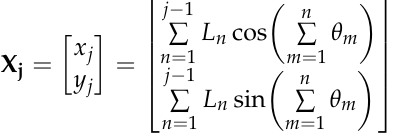
We define the base link as j = 1, where ( x 1 , y 2 ) = (0,0). L j is the length of link j , which appends to joint j , and where θ j is the relative angle between link j and j − 1. Note that for j = N + 1, we obtain the position of the end-effector p with respect to the world frame. Rastegar et al. used the Monte Carlo method [14] while relying on uniformly distributed random values for every joint angle θ j . For every set of joint angles, the end-effector position is calculated using Equation (1), thus forming a cloud of “Monte Carlo points” which represents the workspace plane. Although the angle values are generated uniformly, the non-linearity in Equation (1) leads to a non-uniform distribution of the cloud points within the workspace, as shown in Figure 3a, where most of the points are within the upper outer part of the